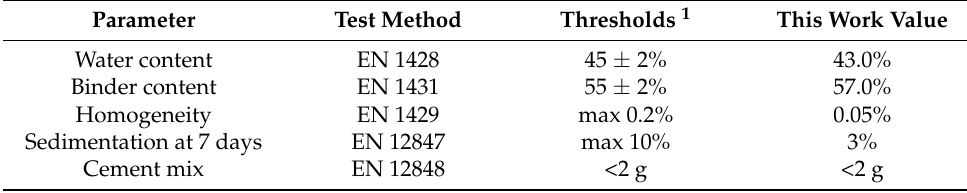
Table 2. Properties of the native bitumen emulsion.